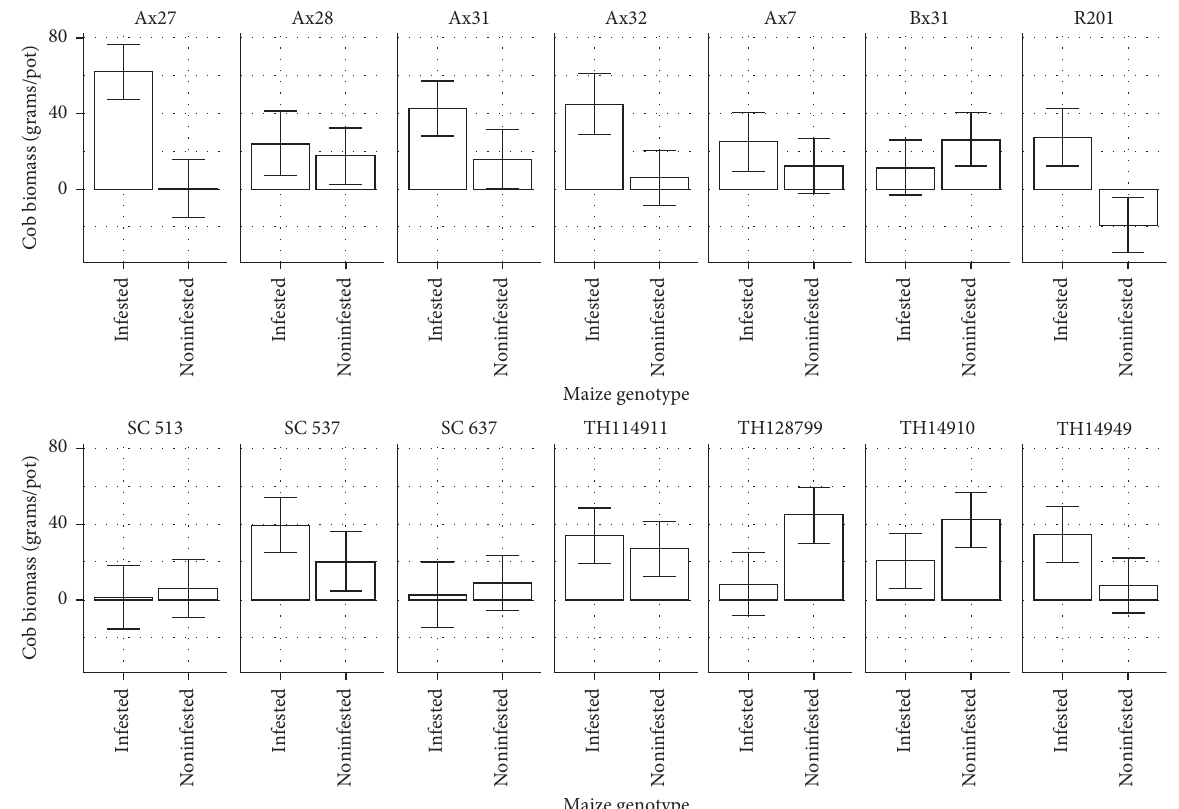
Figure 3: Comparison of cob biomass between Striga infested and noninfested individual genotypes in pot experiment. Error bars indicate the standard errors of the difference between means.